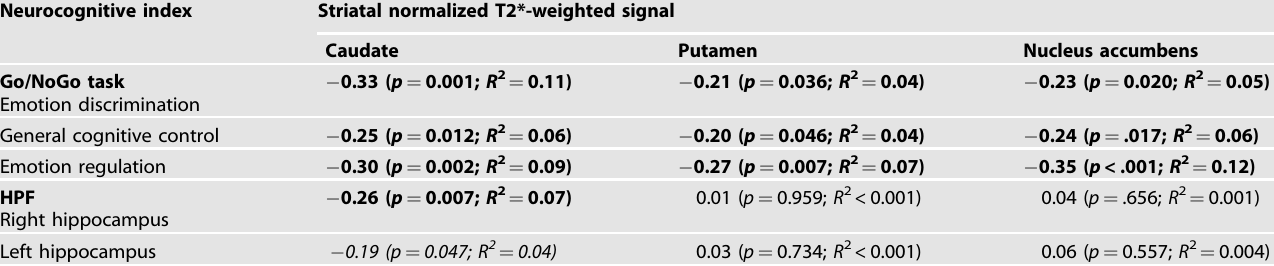
Table 2. Correlation coef fi cients and statistics for relationships of striatal normalized T2*-weighted signal with biobehavioral variables in the study sample.